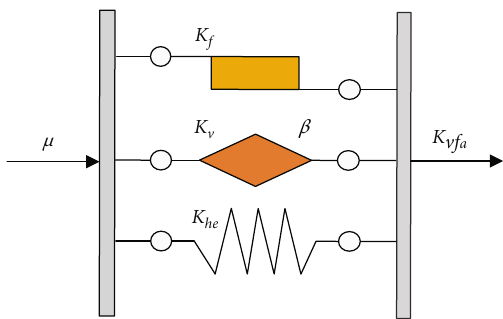
Figure 2: Thermal oxygen aging-dynamic characteristic model of